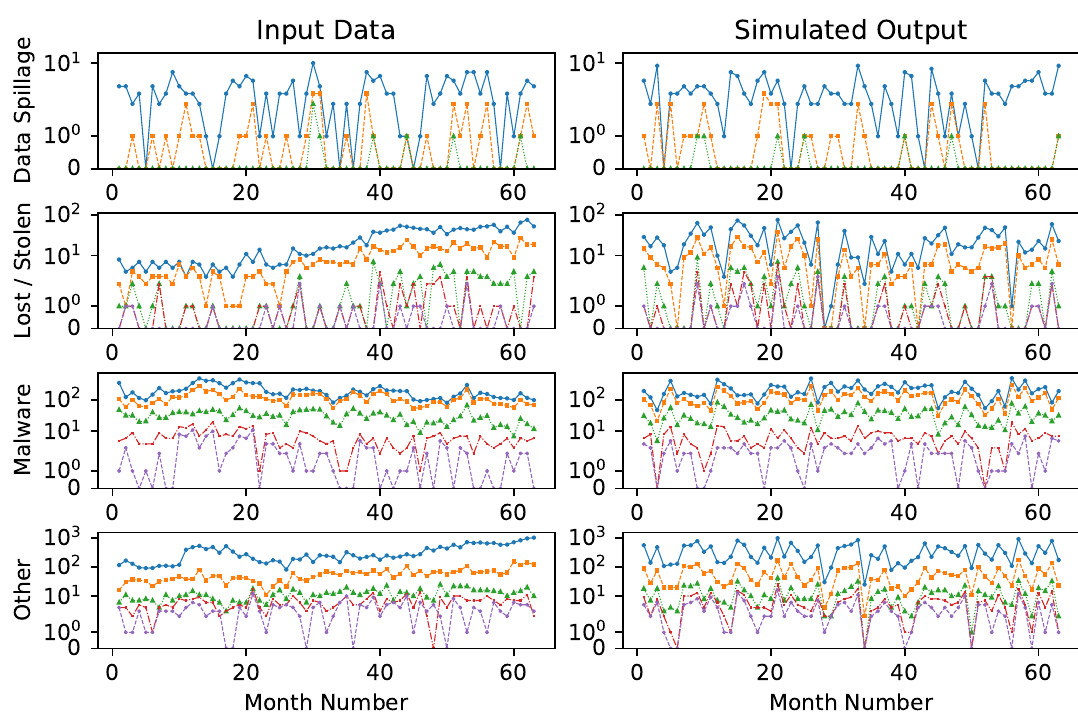
Figure 2. Left hand side: input data over 63 months, extracted from Kuypers et al. (2016) and Paté-Cornell et al. (2018). In each case, the blue line gives the total number of incidents in that month. The lines below the blue give the number of incidents that take more than 2, 5, 10 and 20 h (20 and 50 h for Data Spillage). Right hand side: corresponding output from simulations of the fitted model. Each month is independent of one another, but within a month the number of incidents is